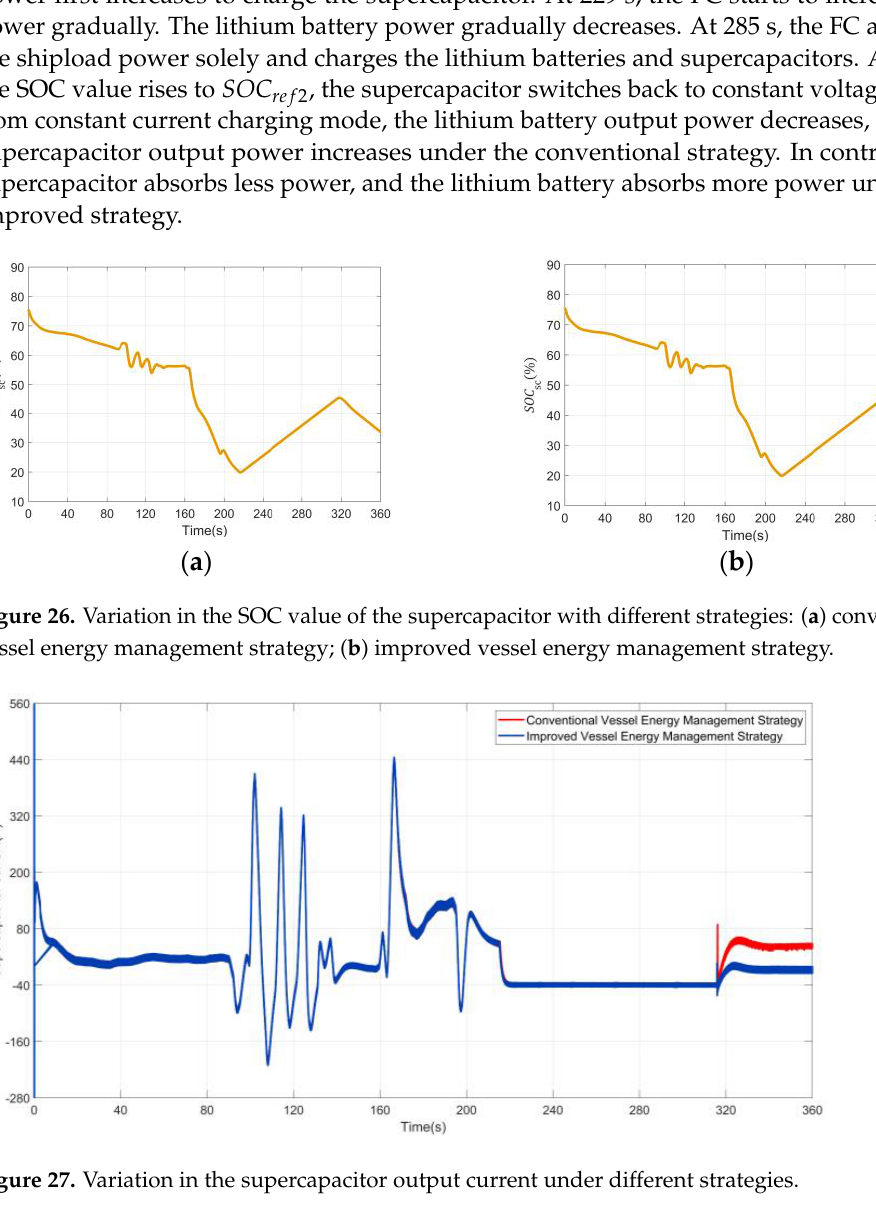
Figure 25. Variation in the SOC value of two lithium batteries under different strategies: ( a ) conven- tional vessel energy management strategy; ( b ) improved vessel energy management strategy.